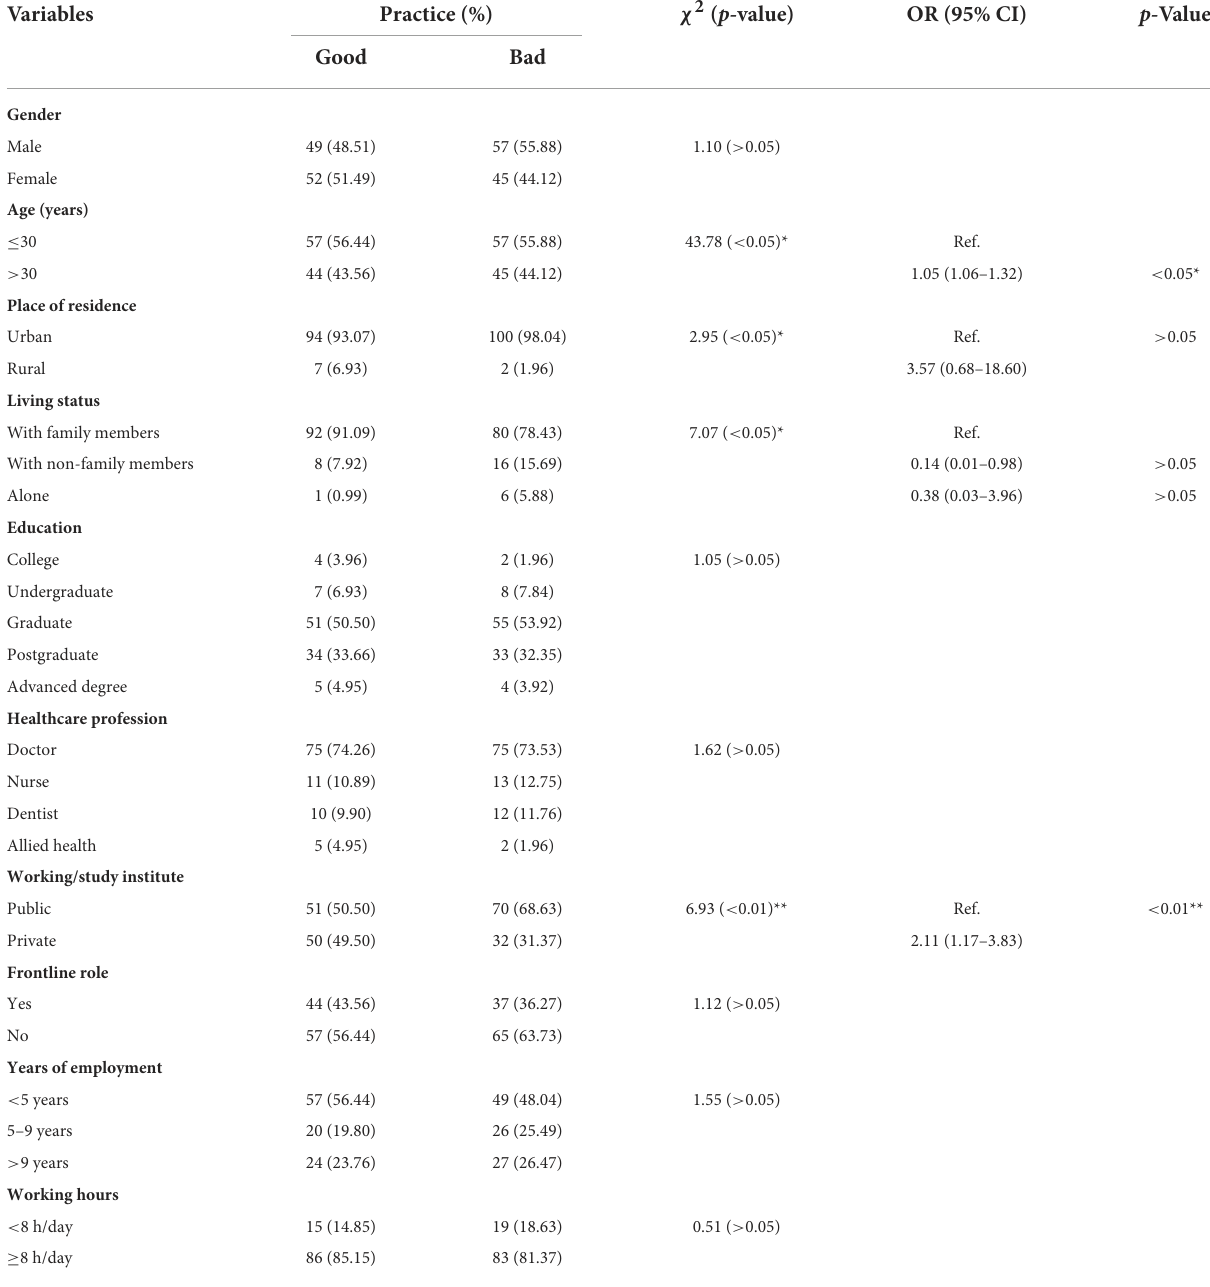
TABLE 7 Factors influencing behavioral practices regarding COVID-19 among healthcare